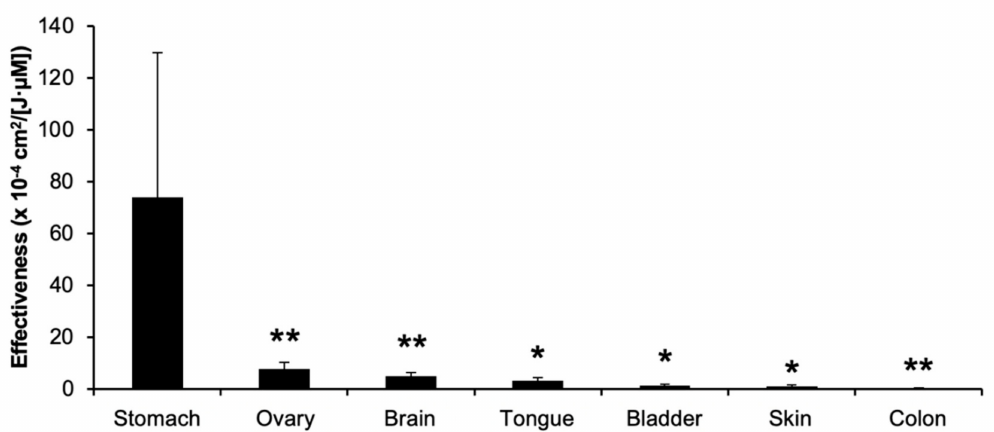
Figure 2. Effectiveness of 5-ALA PDT on cells of different cancer origins. The stomach was identified as the organ most affected by 5-ALA PDT (one-way analysis of variance (ANOVA) with the post hoc Tukey–Kramer test). * p < 0.05 and ** p < 0.01 compared with the stomach. The brain ( n = 18) and ovary ( n = 7) were statistically assessed using the Wilcoxon rank-sum test but showed no significant